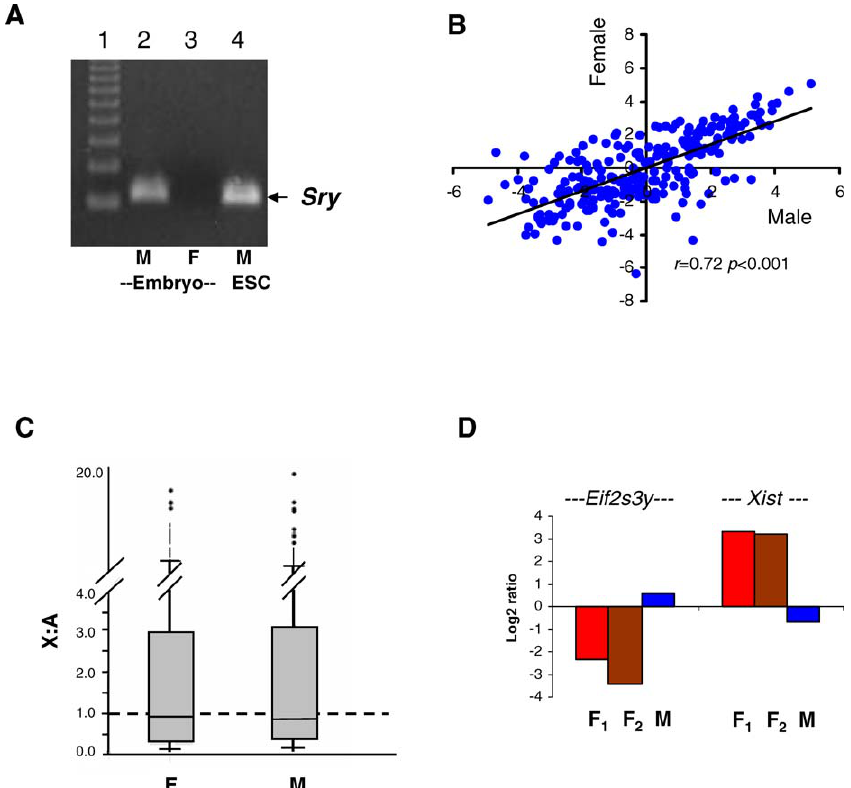
Figure 2. Expression of X-Linked Genes in Male and Female ICM (A) Gel showing presence or absence of PCR products derived from the Sry gene in trophectodermal material from single blastocysts used for ICM cDNA preparation. Lane 1, 123 bp size markers; lane 2, male embryo; lane 3, female embryo; lane 4 male ES cell line CCE/R. (B) Correlation in expression levels of X-linked genes between female ( y -axis) and male ( x -axis) ICMs. The value for each gene is expressed relative to the expression of autosomal genes (X:A ratio, log 2 scale). Pearson product moment correlation coefficient ( r value) and FDR-corrected probability of chance correlation ( p ) are shown. (C) Box plot showing expression of X-linked genes (X:A ratio) in male and female ICMs. The box encompasses the 25th–75th percentile, and the upper and lower lines represent the 10th–90th percentile. Outlying values are shown as individual dots. Female values are from two biological replicates and male values from two technical replicates. (D) Expression of the Y-encoded, male-specific antigen Eif2s3y and Xist RNA, relative to autosomal genes (log 2 ratio), in ICMs from female and male embryos. tion process alone. With this in mind, we co-hybridised red/ green labelled cDNAs from female and male cells, at the same stage of differentiation, to the same slide, and we calculated red:green or green:red ratios as a log 2 ‘‘ M value ’’ , as described [18,19]. In undifferentiated, cells the M value is around 0.65 (Figure 4A), corresponding to a linear female:male expression ratio of about 1.6. M values derived from undifferentiated cells and cells at later stages of differentiation were all normally distributed (Figure 4B). There was no detectable fall in M value for the first 7 d of differentiation, with a small increase at days 2–4. Thereafter, there was a progressive decrease, culminating in an M value close to 0, which reflects equal expression of X-linked genes in female and male cells by day 21 (Figure 4A and 4B). It seems that a net loss of expression of female X-linked genes occurs later than previously concluded on the basis of single-gene analyses [13,20].